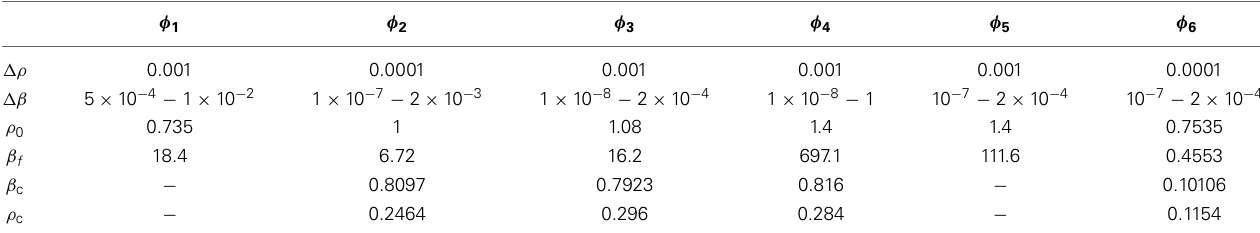
Table 3 | Parameters used in numerical computations for Models 1–6..